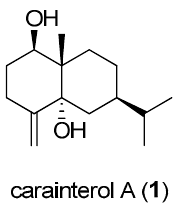
Figure 1. Structure of carainterol A.